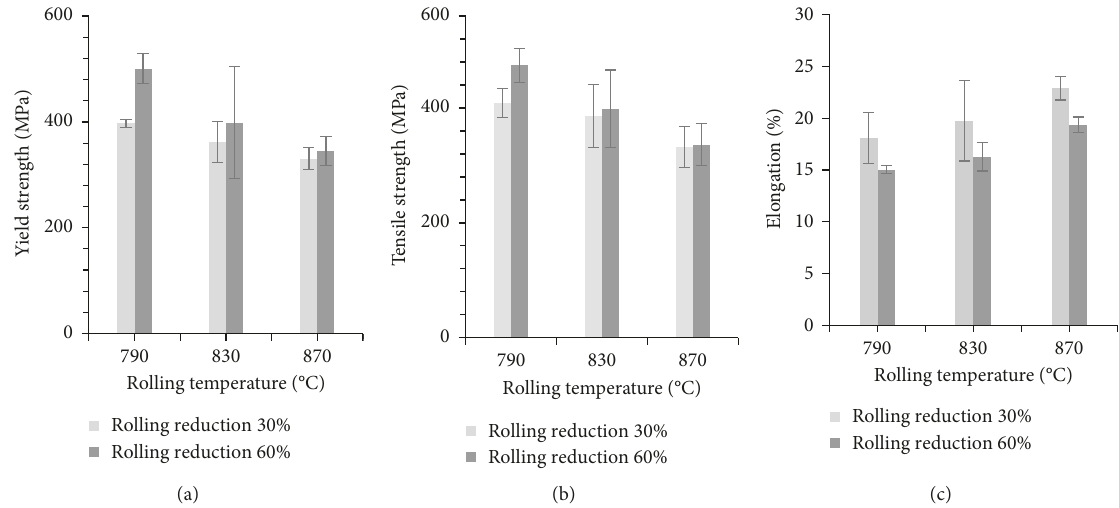
Figure 6: (a) The trend of yield strength values. (b) The trend of tensile strength values. (c) The trend of elongation values for warm rolled steel as function of rolling temperature and rolling